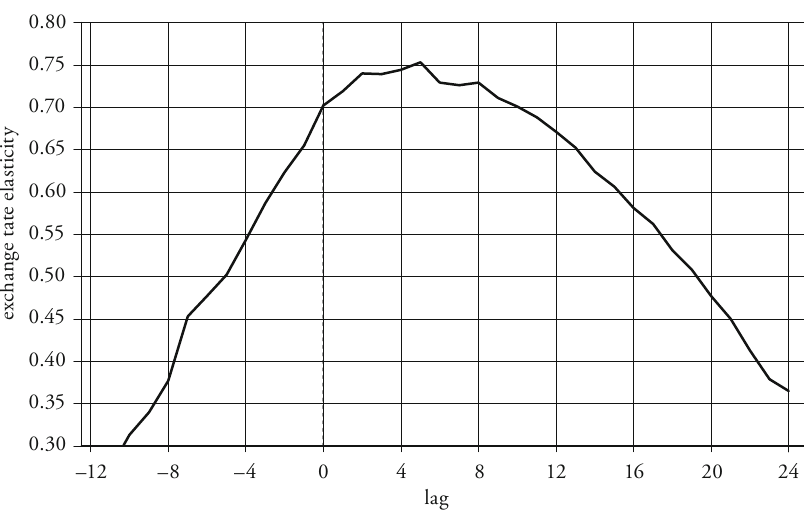
Figure : Exchange Rate Elasticities for Different